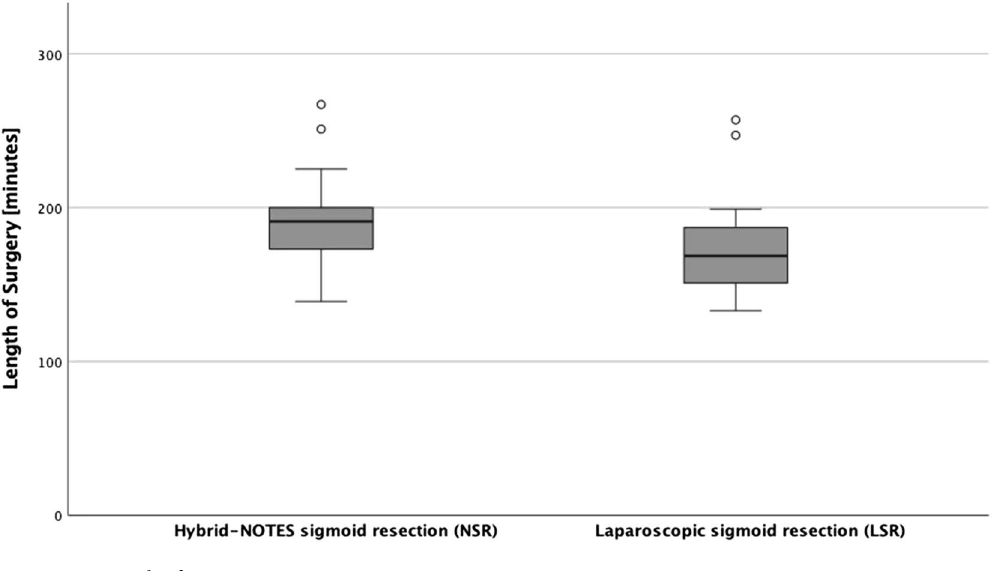
Figure 2. Length of